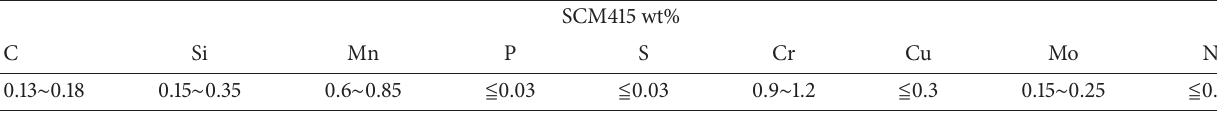
Table 1: Compositions of SCM415.